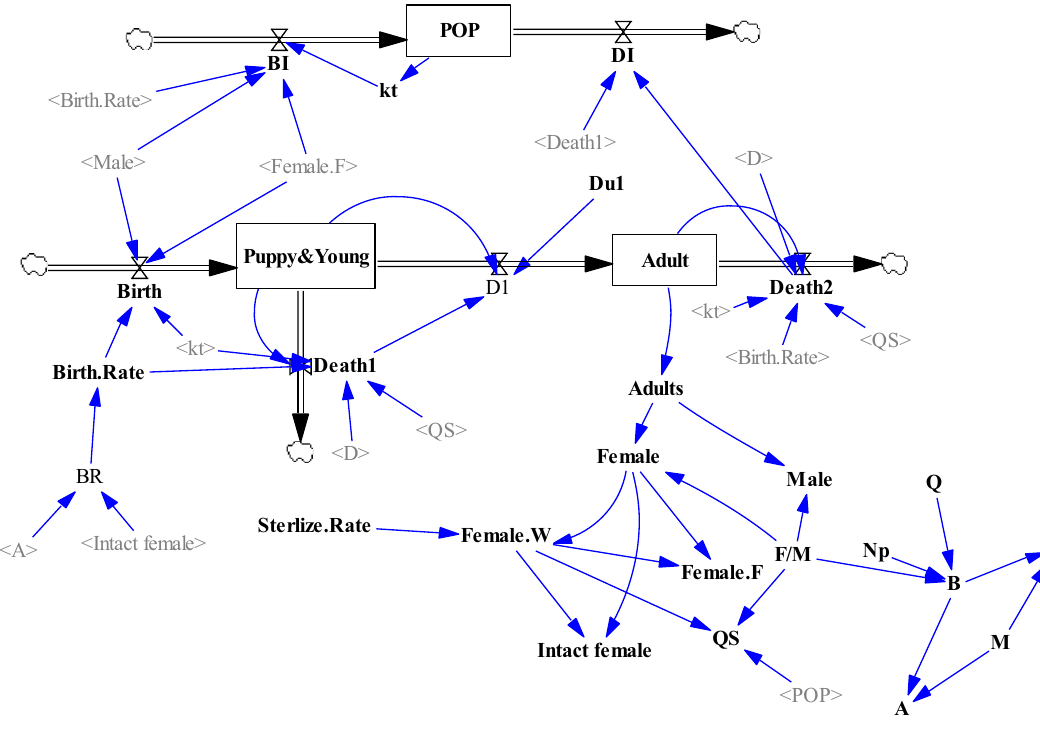
Figure 5. Model of the dynamics of dog population. Dynamic modeling of free-roaming dog population with implementation of animal birth control